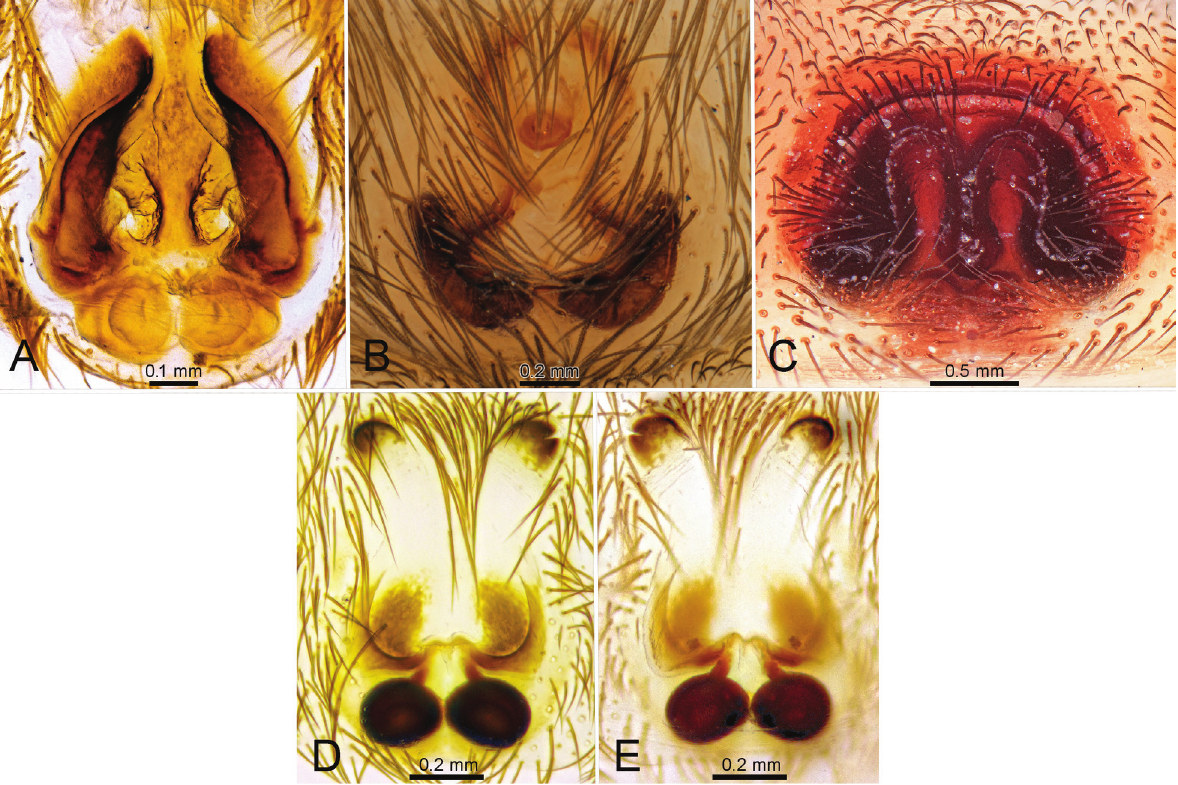
Figure 4. Ventral view of epigynes ( B, C, D ) and dorsal view of vulvae ( A, E ) of gnaphosids. A. Haplodrassus dalmatensis (L. Koch, 1866); B. Minosiella intermedia Denis, 1958; C. Marinarozelotes jaxartensis (Kroneberg, 1875); D, E. Zelotes fagei Denis,